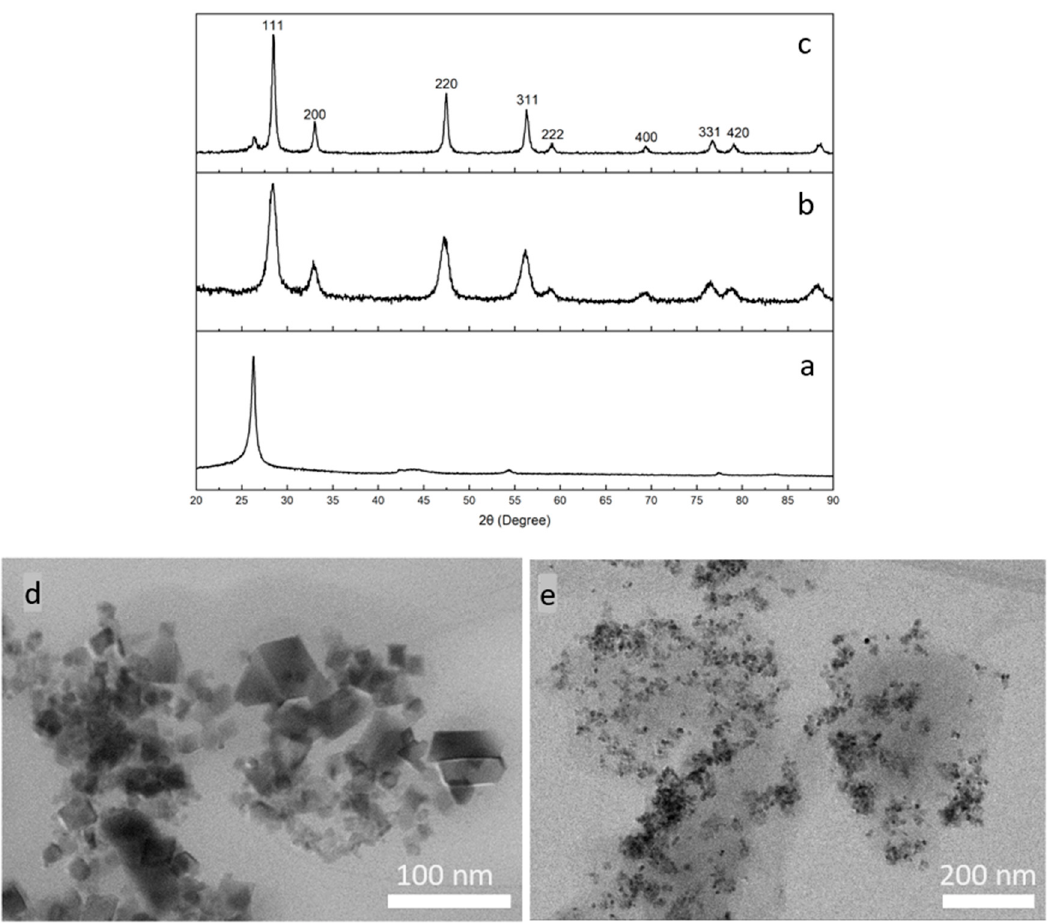
Figure 3. XRD patterns of ( a ) GO, ( b ) CeNPs, and ( c ) CeNP / GO composite; and STEM images of ( d ) CeNPs and ( e ) CeNP / GO composite.